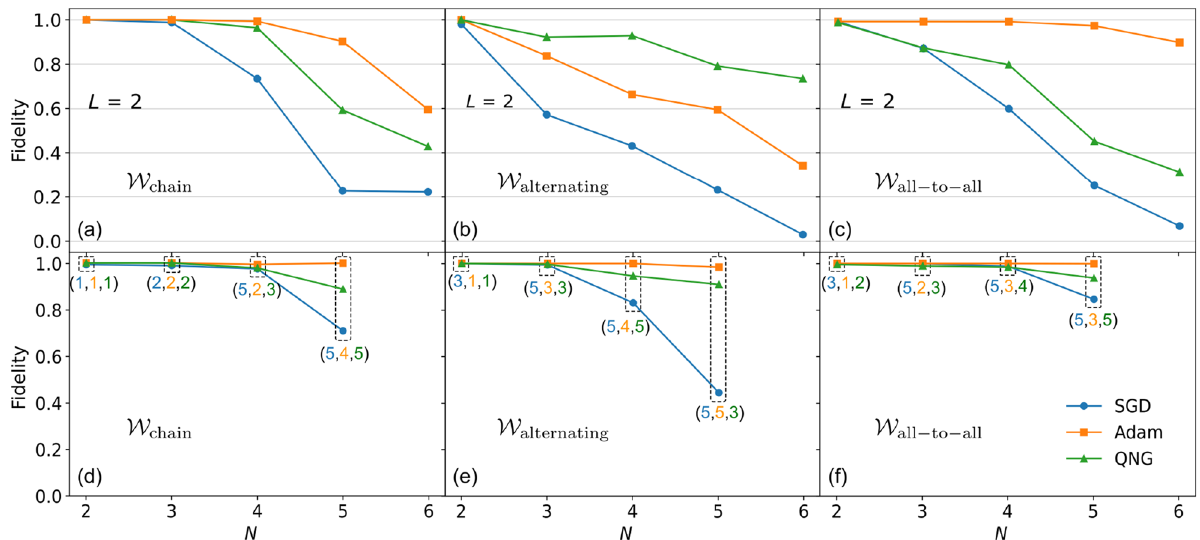
Figure 3. Numerical results for quantum state tomography. ( a – c ) Plot of the fidelity between an unknown φ( θ ) ψ Haar random state and its reconstructed state for different W structures: W chain ( a ), W alternating ( b ), | � | � and W all to all ( c ). For each case, we show the results for different optimizers: SGD, Adam, and QNG. Here we − − 2 . ( d – f ) Plot of the fidelity similar as above for different L as shown in the colored parentheses (blue fixed L = star, yellow dagger, green double dagger). Here, blue star is the optimal number of layers for the SGD, yellow dagger is the optimal number of layers for the Adam, and green double dagger is the optimal number of layers for the QNG. We choose the appropriate (blue star, yellow dagger, green double dagger) for each N and each W structure so that the fidelity gets its (possible) highest